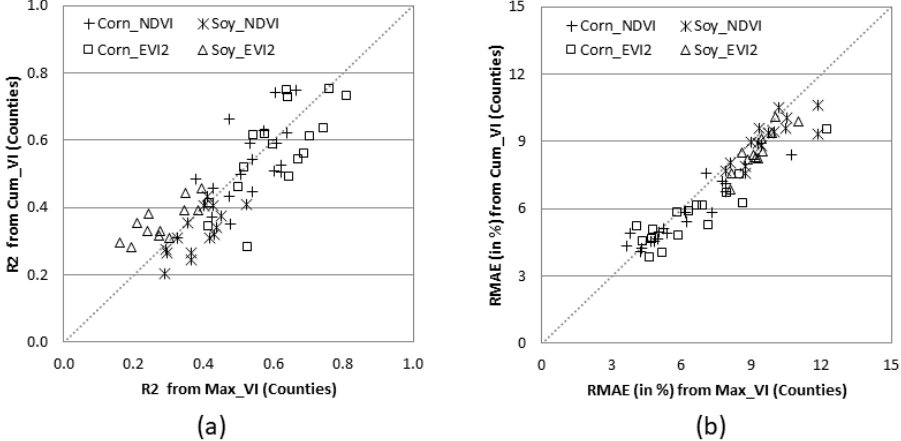
Figure 11. Comparison of R 2 ( a ) and RMAE ( b ) from each county for small cumulative (day 192–236) and maximum VIs for corn and soybeans. Each point shows statistics for one county from 2001–2015. Statistics that are not significant ( p -value < 0.05) from both Max_VI and Cum_VI are excluded.